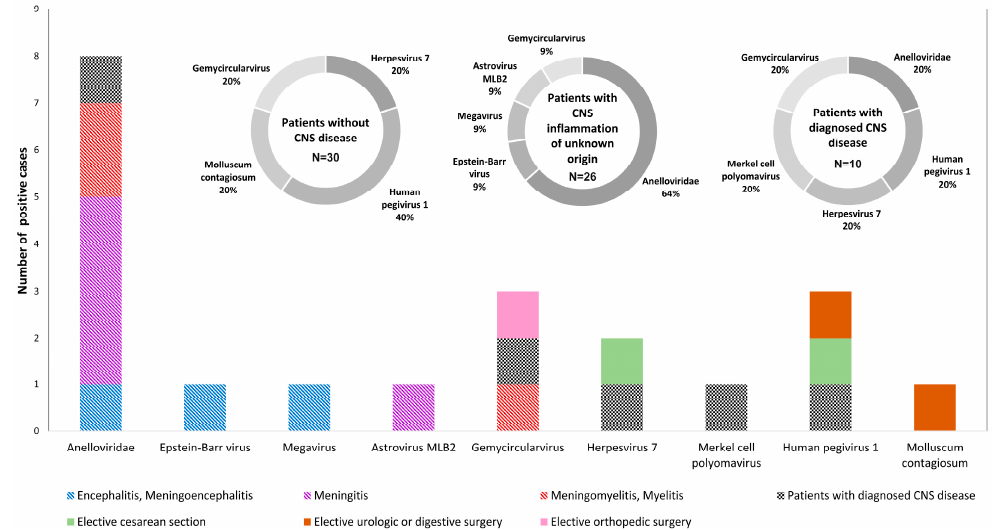
Figure 2. Schematic representation of the different RNA and DNA viruses detected by high throughput sequencing (HTS) in patients with and without CNS disease.